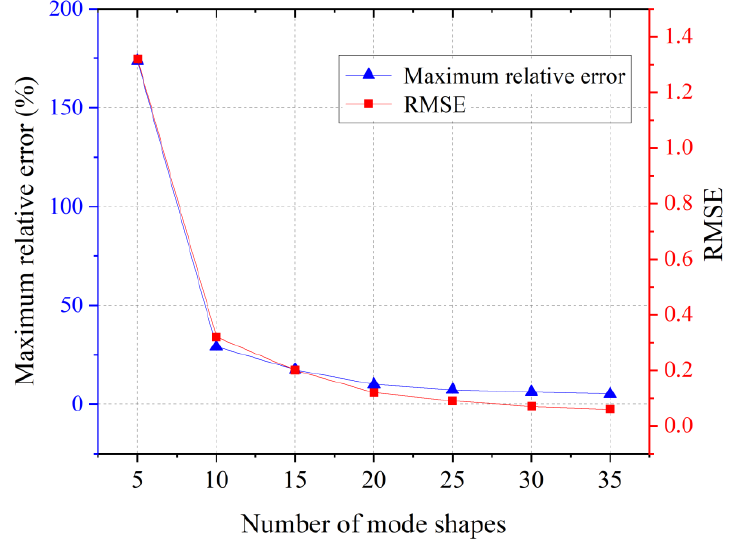
Figure 6. Accuracy of the verified configurations computed by initial global POD ROM: ( a ) RMSE values; and ( b ) energy – frequency curves of the No.1 verified configuration.